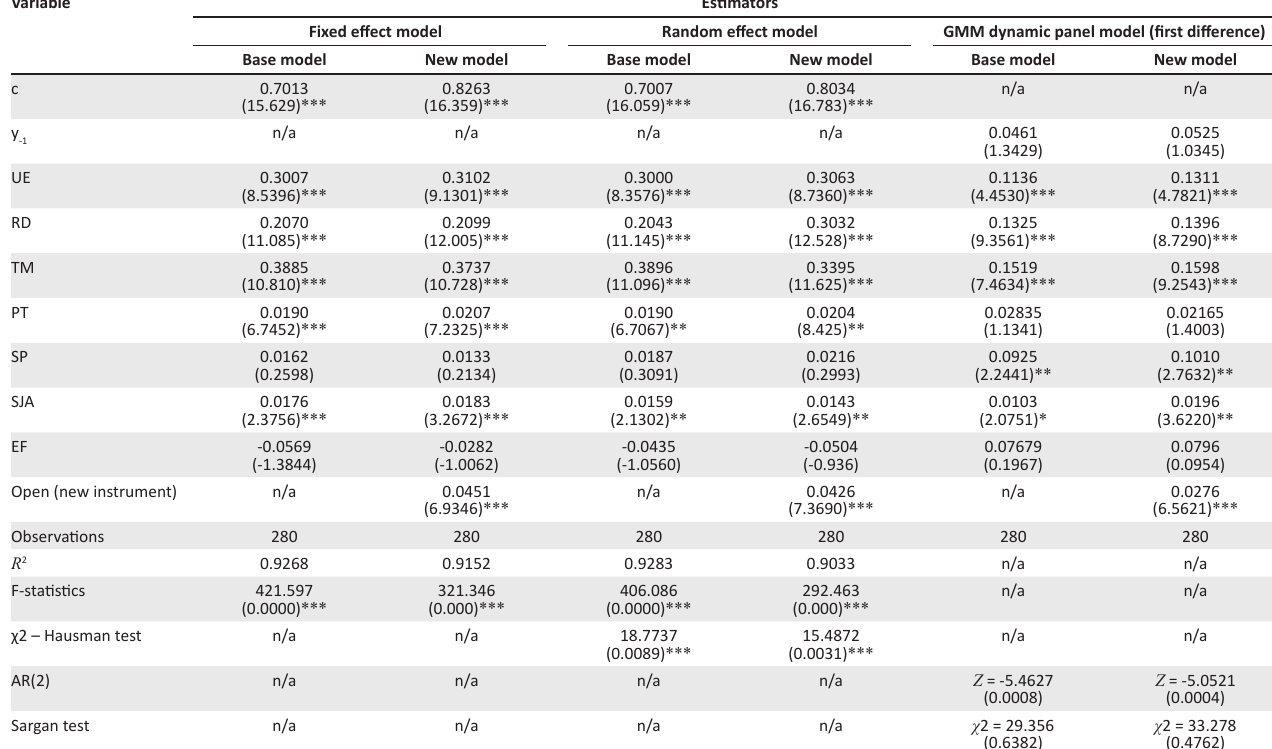
TABLE 4: Robustness check of the panel data estimate.